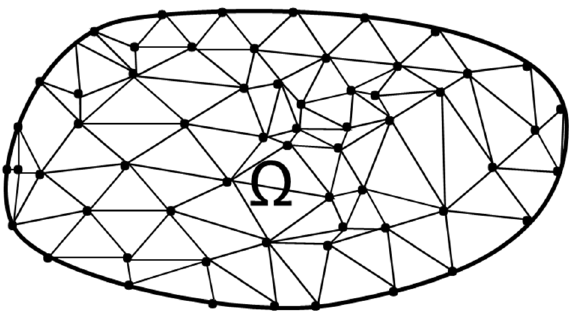
Figure 6. Visual representation of the Finite Element Method (FEM) with a finite element triangu- lar mesh.